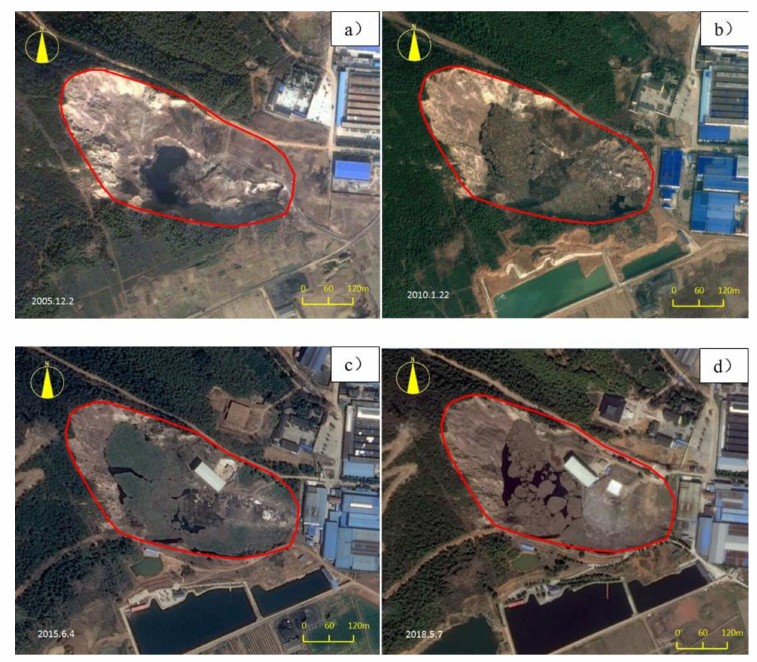
Figure 1. Historical Google satellite images of landfills: ( a ): 2005; ( b ): 2010; ( c ): 2015; ( d ): 2018.